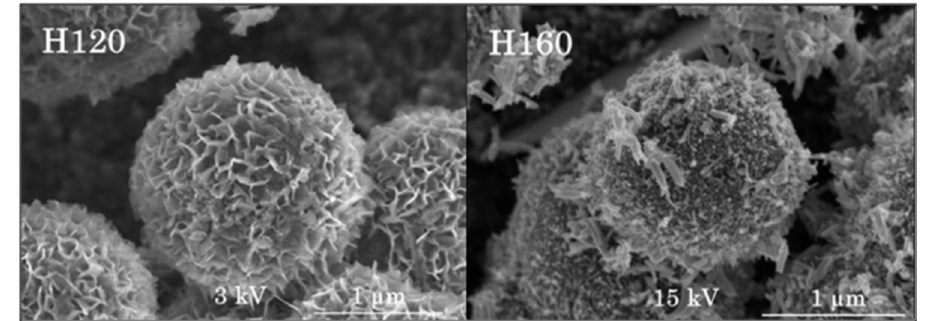
Figure 13. SEM images of TiO 2 /G nanocomposites prepared by HT method at 120 °C (H120) and 160 °C (H160). Reprinted with permission from reference [100]. Copyright 2014 Elsevier.